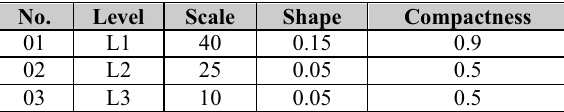
Table 1: Parameters used for segmentation hierarchy From a plethora of image object attributes; ‘Mean Object Value’, relation to super object and hierarchy, were considered